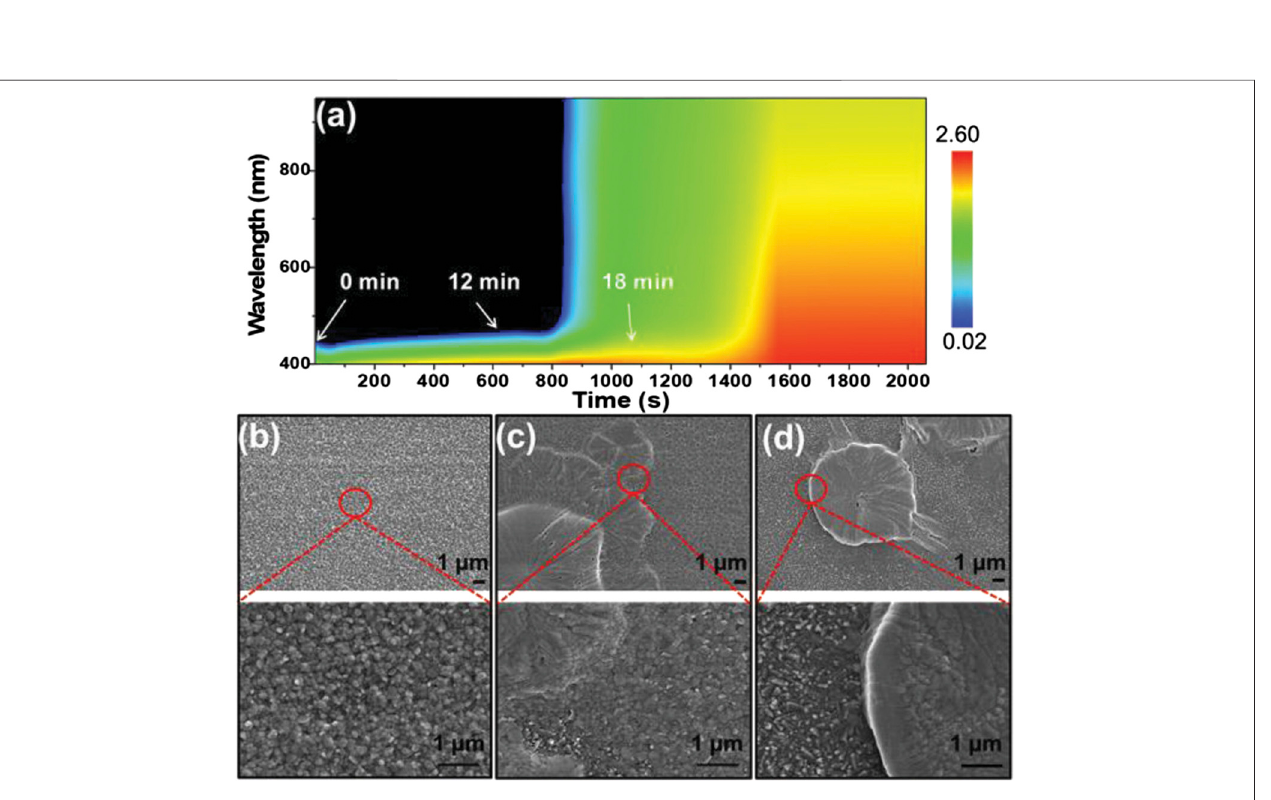
FIGURE 3 |(A) In situ time-resolved UV-Vis absorption spectra of the blade-coated perovskite wet fi lm. SEM imagesof the perovskite fi lms receiving gas-assisted dryingat (B) t (cid:2) 0 min, (C) t (cid:2) 12 min,and (D) t (cid:2) 18 minaftertheprecursorwet fi lmswereblade-coated.ReprintedwithpermissionfromHuetal.(2019).Copyright2019 WILEY-VCH Verlag GmbH & Co. KGaA,